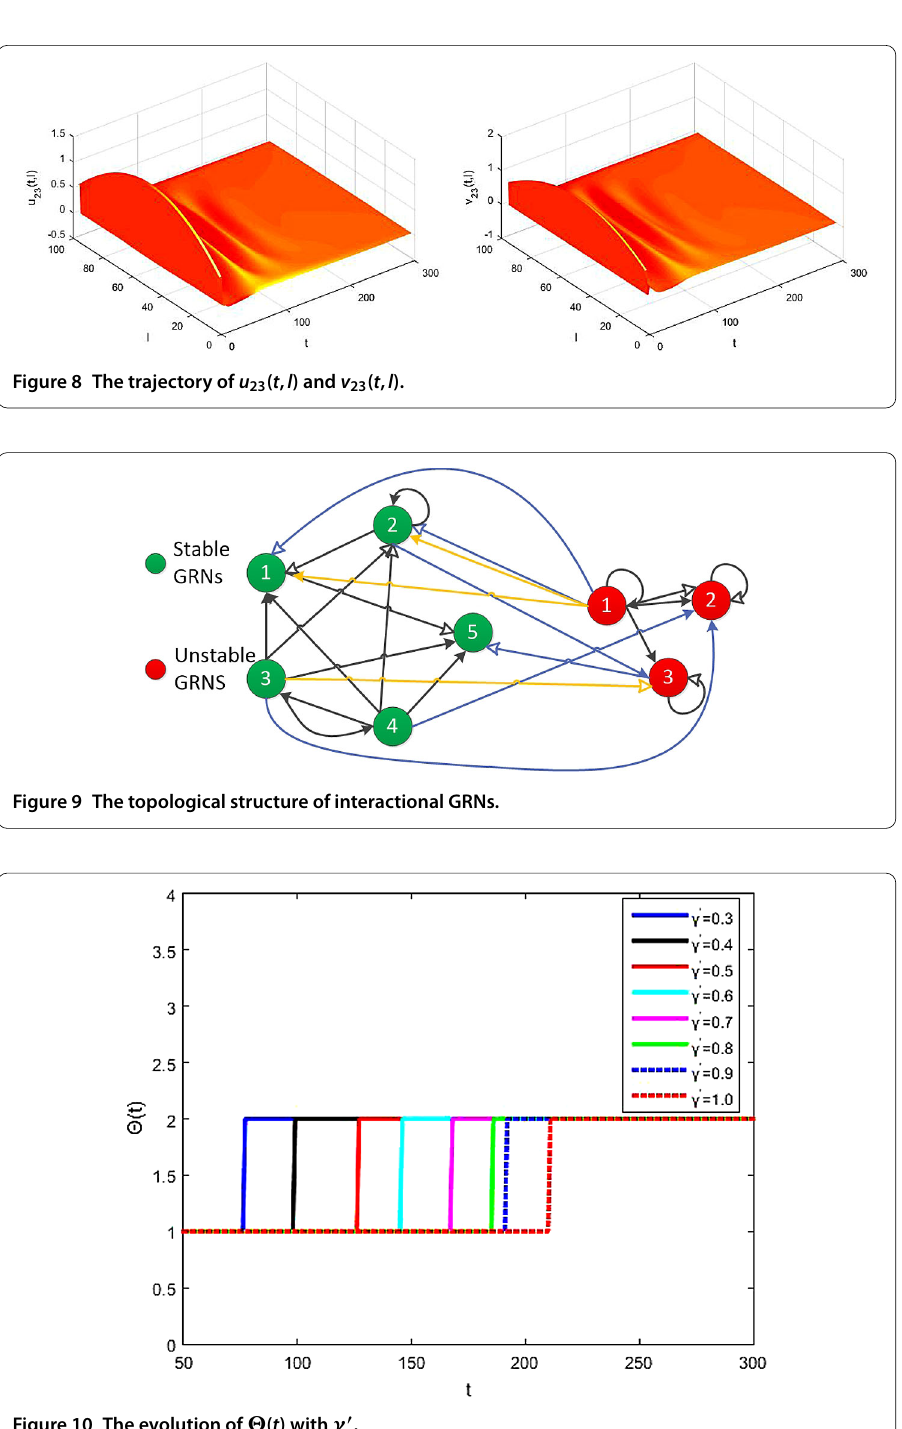
Figure 10 The evolution of (cid:2) ( t ) with γ (cid:3)